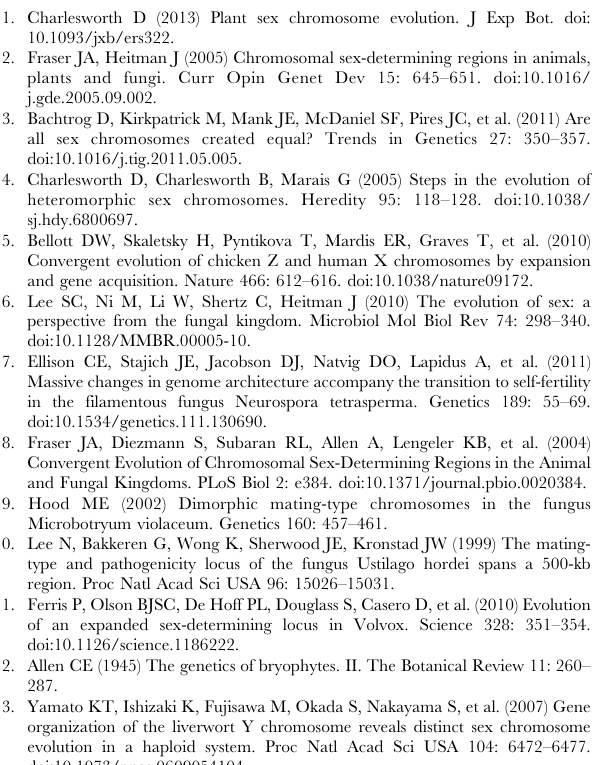
were scored for additional markers in the indicated genes. The first 8 markers are in MT and listed in the order they occur on chromosome 6. MMP1 , YPT4 and GP1 are unlinked to MT and were used as controls to show independent assortment of autosomal markers in the cross. Nic and Thi columns indicate auxotrophy ( 2 ) or prototrophy ( + ) for nicotinamide and thiamine respectively. Table S9 Recombination data for MT 2 homozygous cross. 1. recombinant progeny/total progeny. 2. Expected recombinants for MAT3-PDK1 and for MID-NIC7 are based on the genome- wide average of , 1 cM/100 kb. For 4121-MT and GAR1-GSAT the expected value is based on previous data [49]. Table S10 List of oligonucleotides used in this study. a primers derived from [78]. b primers derived from [79]. c primers derived from